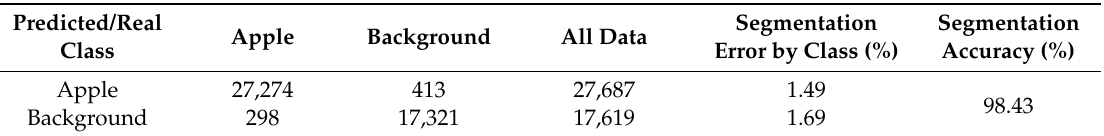
Table 4. Confusion matrix, segmentation error, and accuracy of the segmentation algorithm for identifying background objects and apples on the test